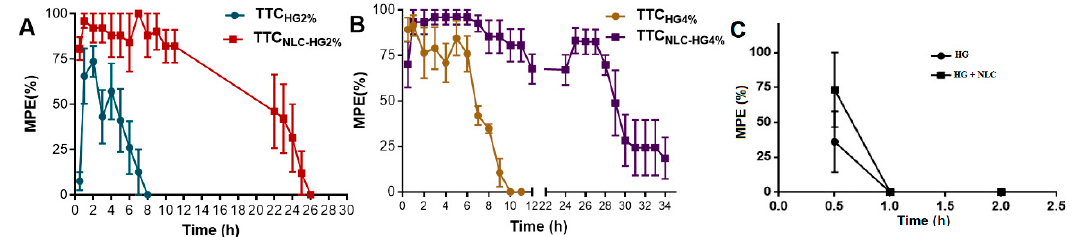
Figure 5. Anesthetic effect (tail-flick test) in mice treated with: ( A ) TTC HG2% and TTC NLC-HG2% ; ( B ) TTC HG4% and TTC NLC-HG4% ; and ( C ) PL407 hydrogel (HG) and NLC incorporated in HG (HG + NLC). The results are expressed as maximum possible effect (%MPE) vs. time (h). The data are shown as mean ± SEM ( n = 6).